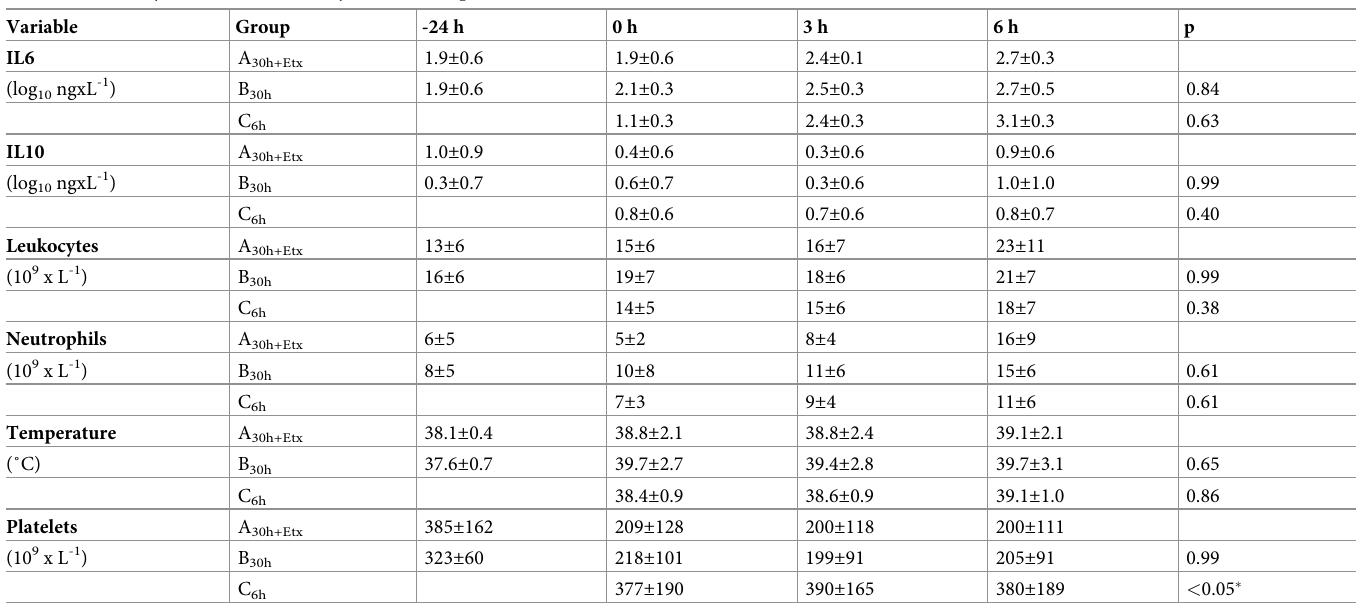
Table 4. Plasma cytokines, inflammatory cells and temperature.